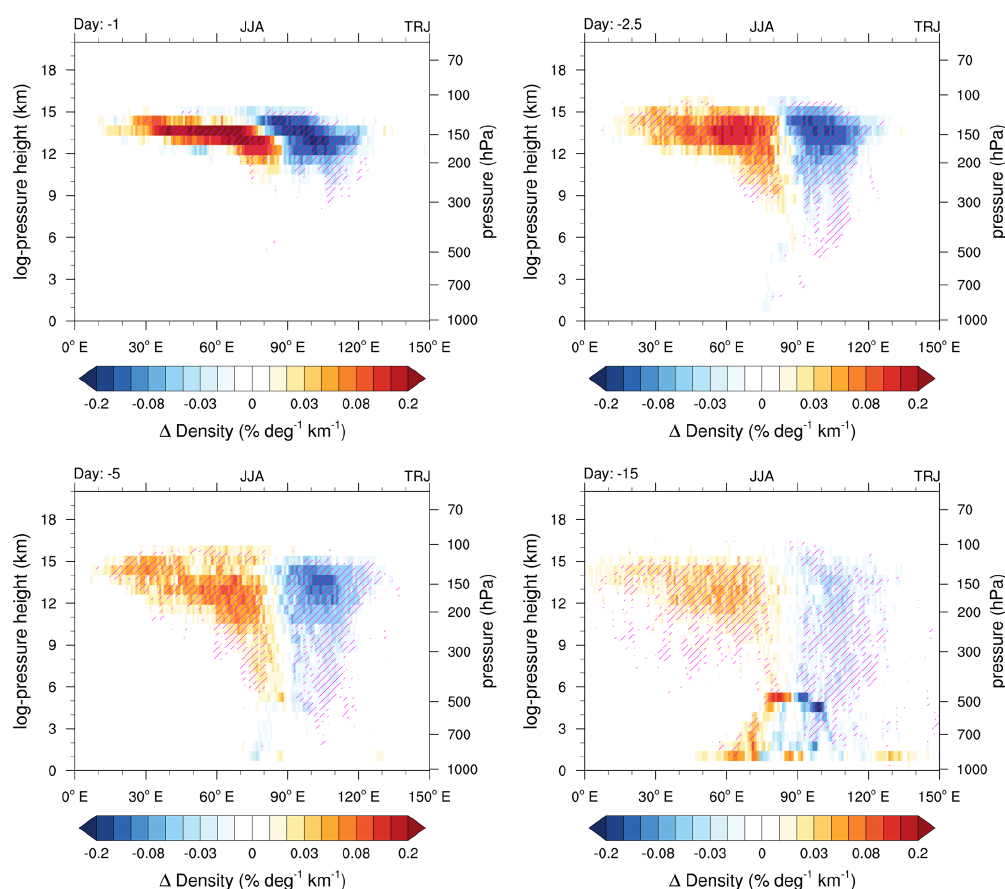
Figure 8. Longitude versus log-pressure height cross sections of the difference (west minus east years) of the density distributions (%deg − 1 km − 1 ) of trajectory positions for PBL crossing trajectories 1, 2.5, 5 and 15d prior to their arrival at 150hPa within the AMA. The three-dimensional probabilities were integrated over 0–50 ◦ N. Once trajectories reach the PBL, they are not tracked further and will also be noted at the crossing point further back in time (as in Fig. 5). Magenta hatching indicates the 0.1 significance